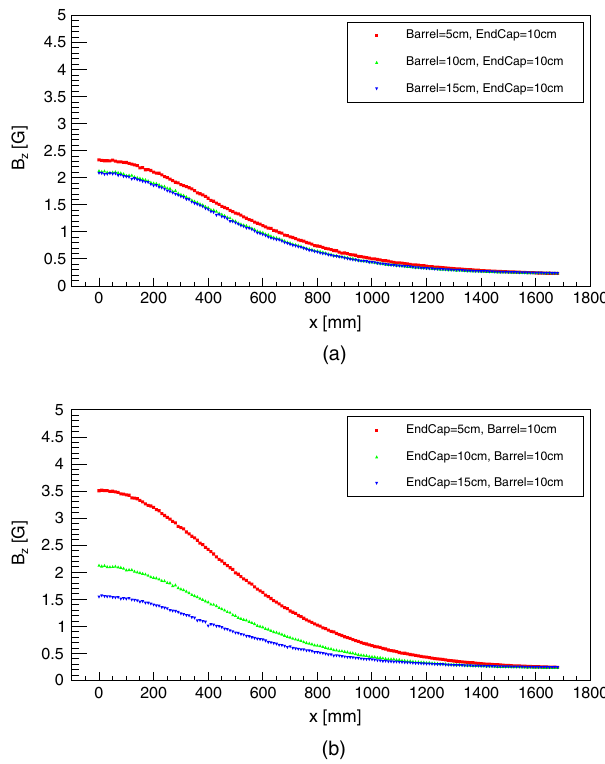
FIG. 13. Model 1: the stray field component B z of the solenoid WSY along the EM-S beam section for different thicknesses of the iron housing. (a) WSY with different barrel thicknesses and end cap thicknesses fixed at 10 cm; (b) WSY with different end cap thicknesses and barrel thicknesses fixed at 10 cm.